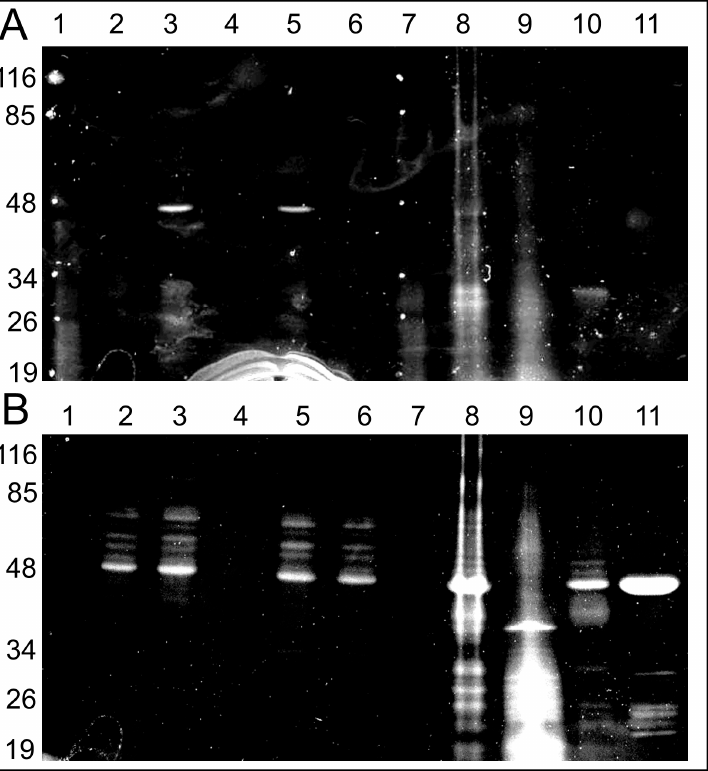
Figure 4. Fluorescent images of the gels after SDS electrophoresis of solubilized rat liver or heart mitochondria (RLM or RHM) exposed to C4R1 (5 µ M) under different conditions ( A ). In ( B ), the same gel is shown but after its incubation with C4R1 (20 µ M). Lanes: 1. MW markers; 2. RLM 40 µ g protein; 3. RLM+C4R1; 4. RLM+C4R1+NaOH; 5. RLM+C4R1+FCCP; 6. RLM+FCCP; 7. MW markers; 8. frozen RHM 40 µ g protein. No dye; 9. Fraction 1800 g of RHM. No dye; 10. Fraction 8000 g of RHM. No dye; 11. Isolated ATP synthase. No dye.